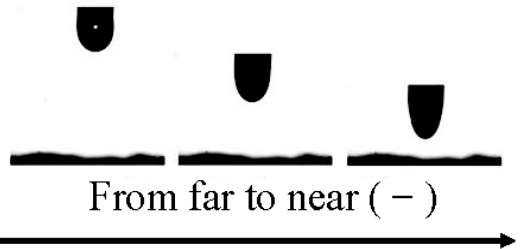
Figure 12. The interaction between the 0.02% AEO-9-charged droplets and coal dust particles.